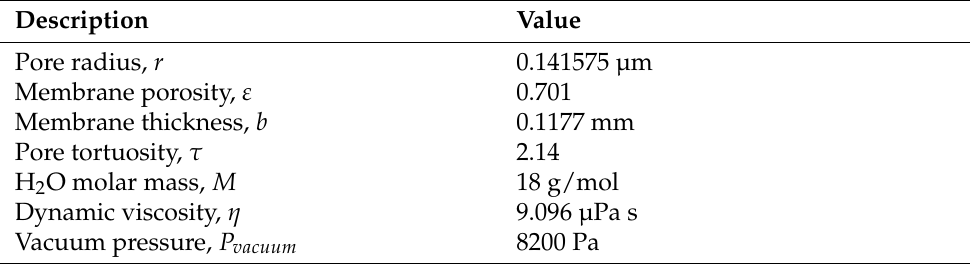
Table 3. Values implemented in VMD modeling.